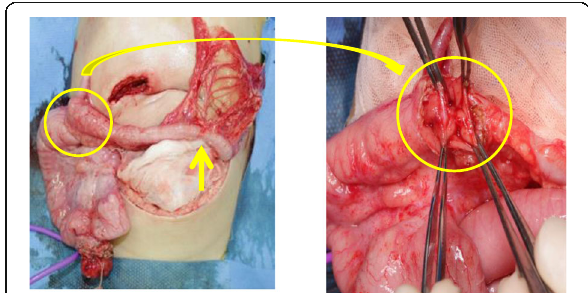
Fig. 4 Operative findings. The continuity of the intestinal serosal surface was maintained, while, as for the lumen, there were membranous atresias in the Bauhin ’ s valve and anus, 2 cm from the Bauhin ’ s valve (circle), and a membranous atresia in the transverse colon and stricture in the anus, 2 cm from the atresia (arrow)